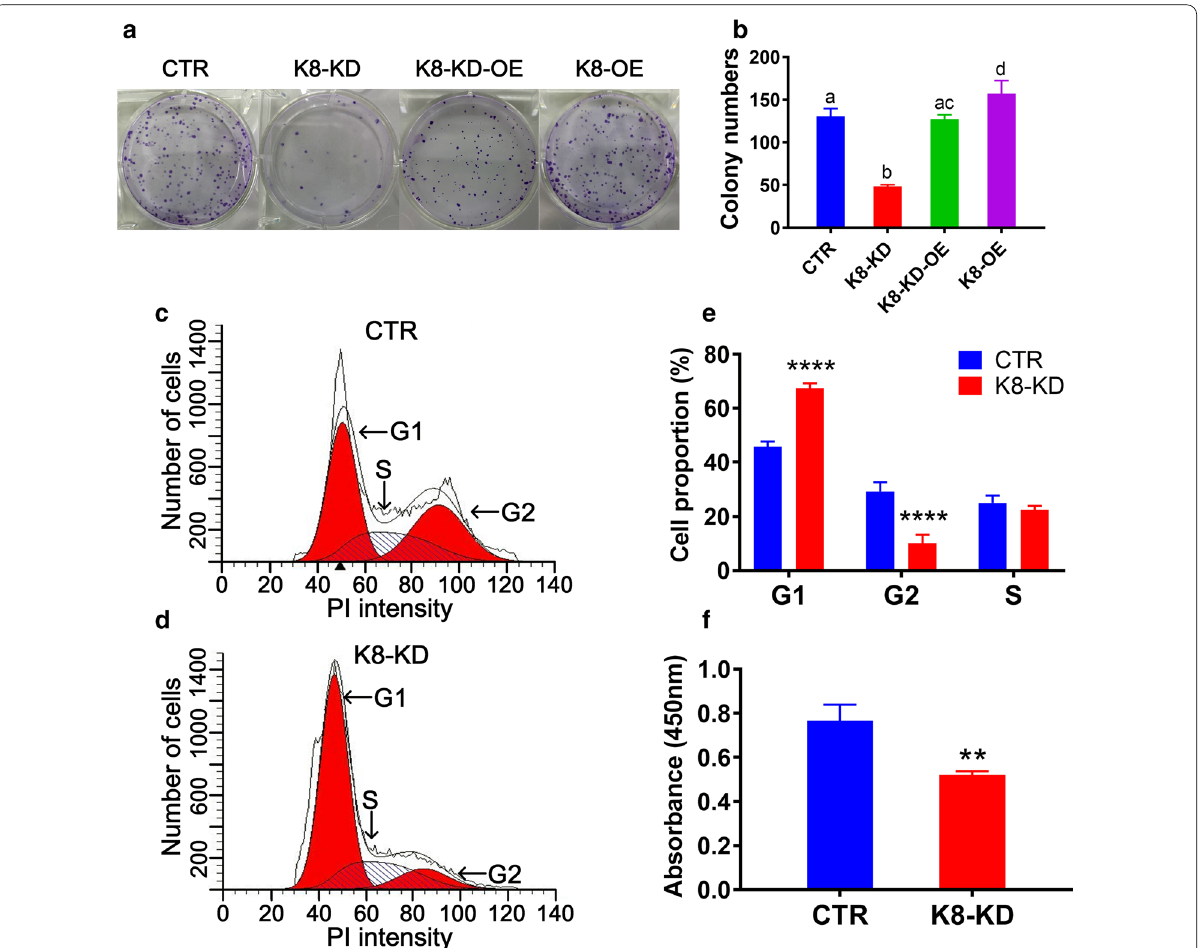
Fig. 3 Human KBTBD8 was important for the proliferation of EOC cells. a , b The colony number in K8‑OE group was significantly more than control group, whereas the colony number in K8‑KD‑OE group was more than K8‑KD group while close to control group (Colony number, CTR vs. K8‑KD vs. K8‑KD‑OE vs. K8‑OE, 130 vs. 48 vs. 127 vs. 157). c – e Cell cycle analysis by FACS showed that significantly fewer cells were at the G2 stage (proportion of cells at G2, CTR vs. K8‑KD, 29.22% vs 10.09%) and more cells were at the G1 stage (percentage of cells at G1, CTR vs. K8‑KD, 45.72% vs. 67.39%) in KBTBD8‑knockdown A2780 cells than in control cells. PI, Propidium Iodide. f CCK8 assay showed that there were less proliferating cells in the KBTBD8‑knockdown A2780 cells than in control cells (CCK8, CTR vs. K8‑KD, 0.7672 vs. 0.5211). A.U., arbitrary unit. Different characters above the column between groups indicate significant difference. **Indicates p < 0.01, ****indicates p <